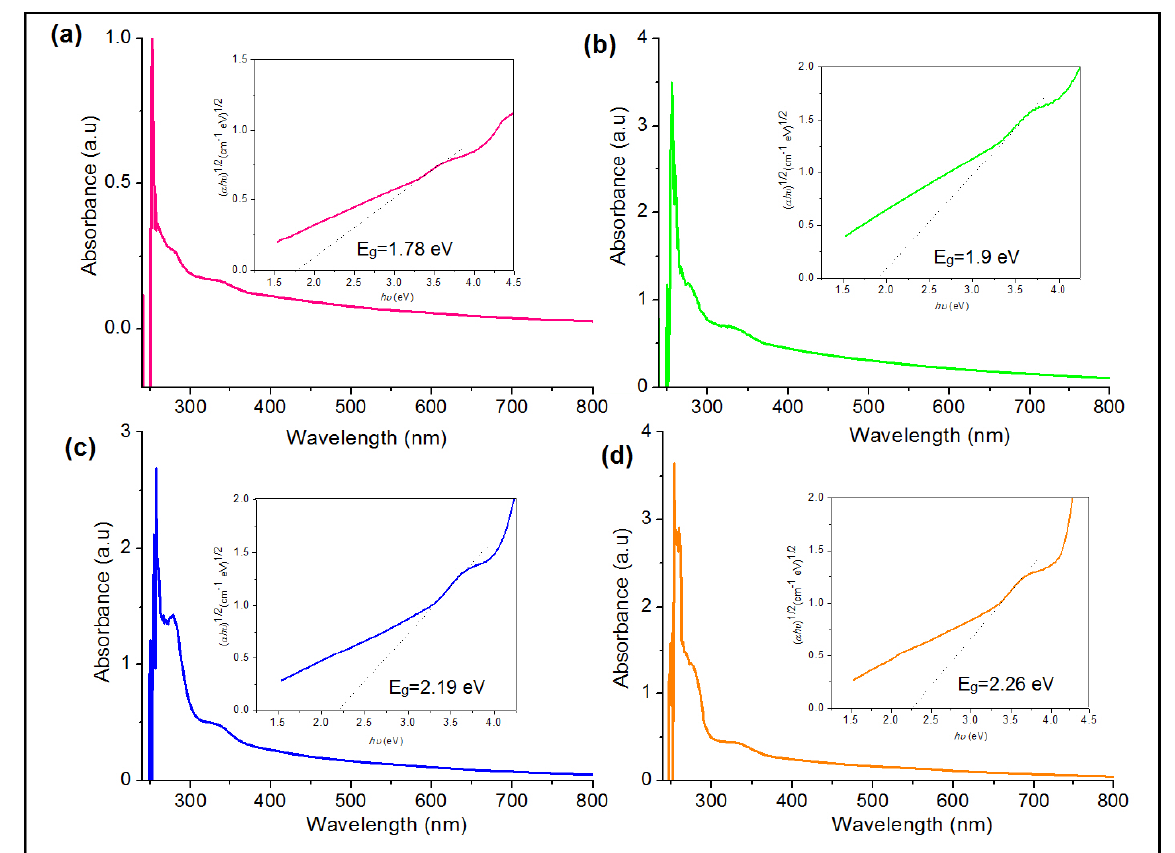
Figure 4. Absorption spectra of PVA/PPy/KI/I 2 electrolytes with various plasticizers (in wt.%); ( a ) EC, ( b ) PC, ( c ) GBL, and ( d ) DBP. The inset shows the indirect band gap. Table 2. Indirect band gap energy of the PVA/PPy/KI/I 2 electrolyte with different plasticizers.